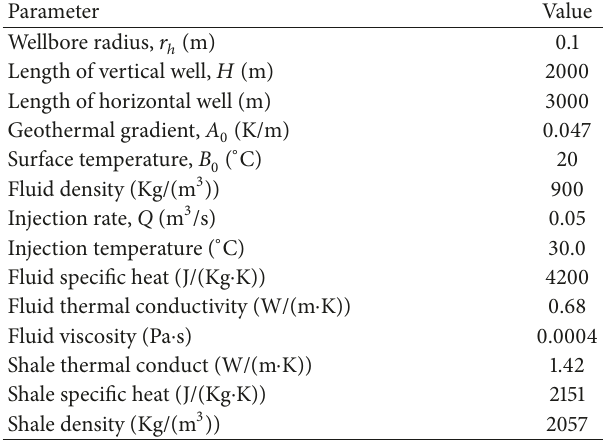
Table 1: Physical parameters for the present calculation (the param- eter values for thermal properties of shale are from Eppelbaum et